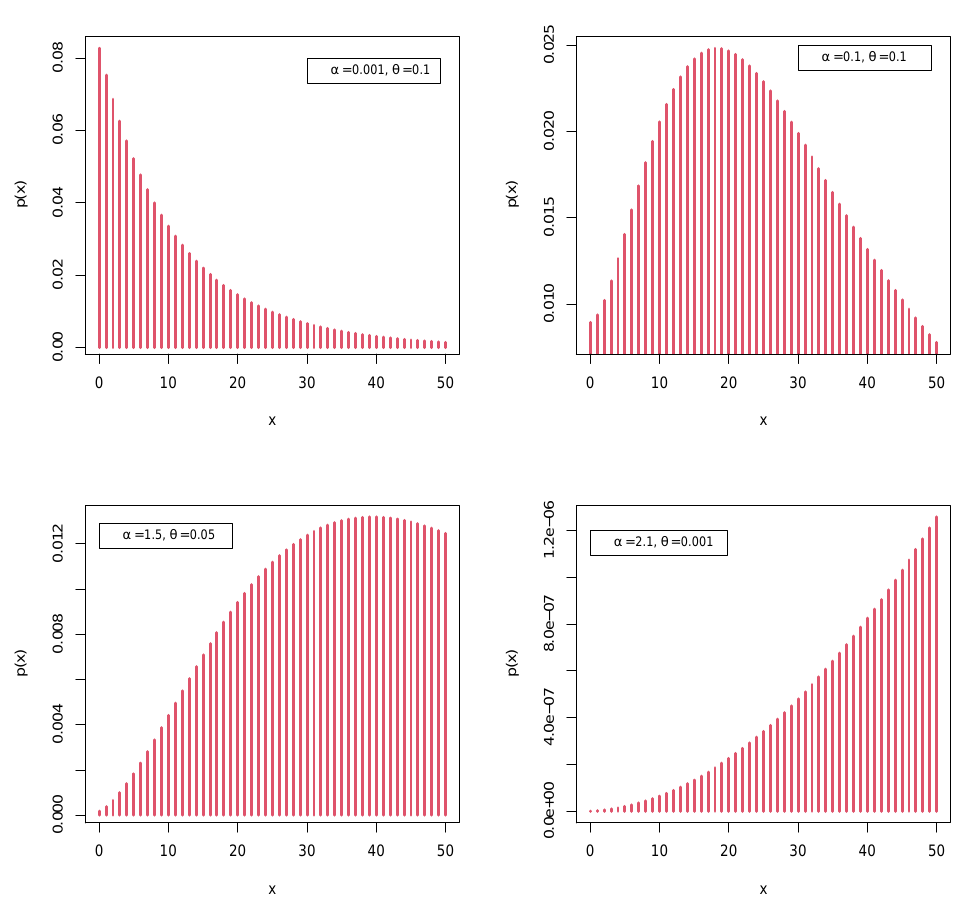
Figure 2. Plots of the pmf of the PMiD. The pmf appears to be declining, growing, and unimodal, with some fluctuation in the mode and